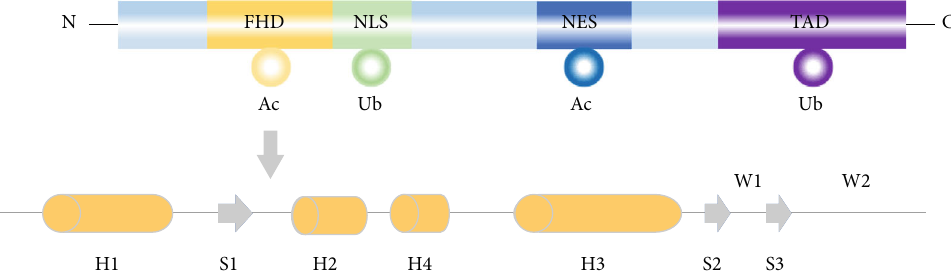
Figure 1: The structure of FOXO1. From the N terminus to the C terminus, FOXO1 contains a forkhead DNA-binding domain (FHD), a nuclear localization signal (NLS), a nuclear export sequence (NES), and a transactivation domain (TAD). Ac: acetylation; Ub: Table 1: Phosphorylation sites in FOXO1